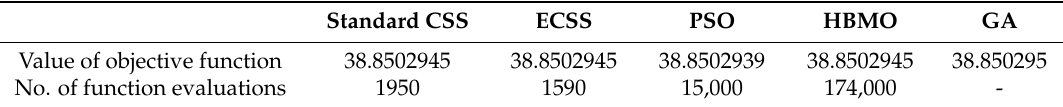
Figure 2. Surface of the unconstrained sine function ( a ) and the constrained exponential function ( b ). Table 2. Results of the standard CSS and ECSS algorithms in comparison with the other heuristics for the unconstrained sine function.